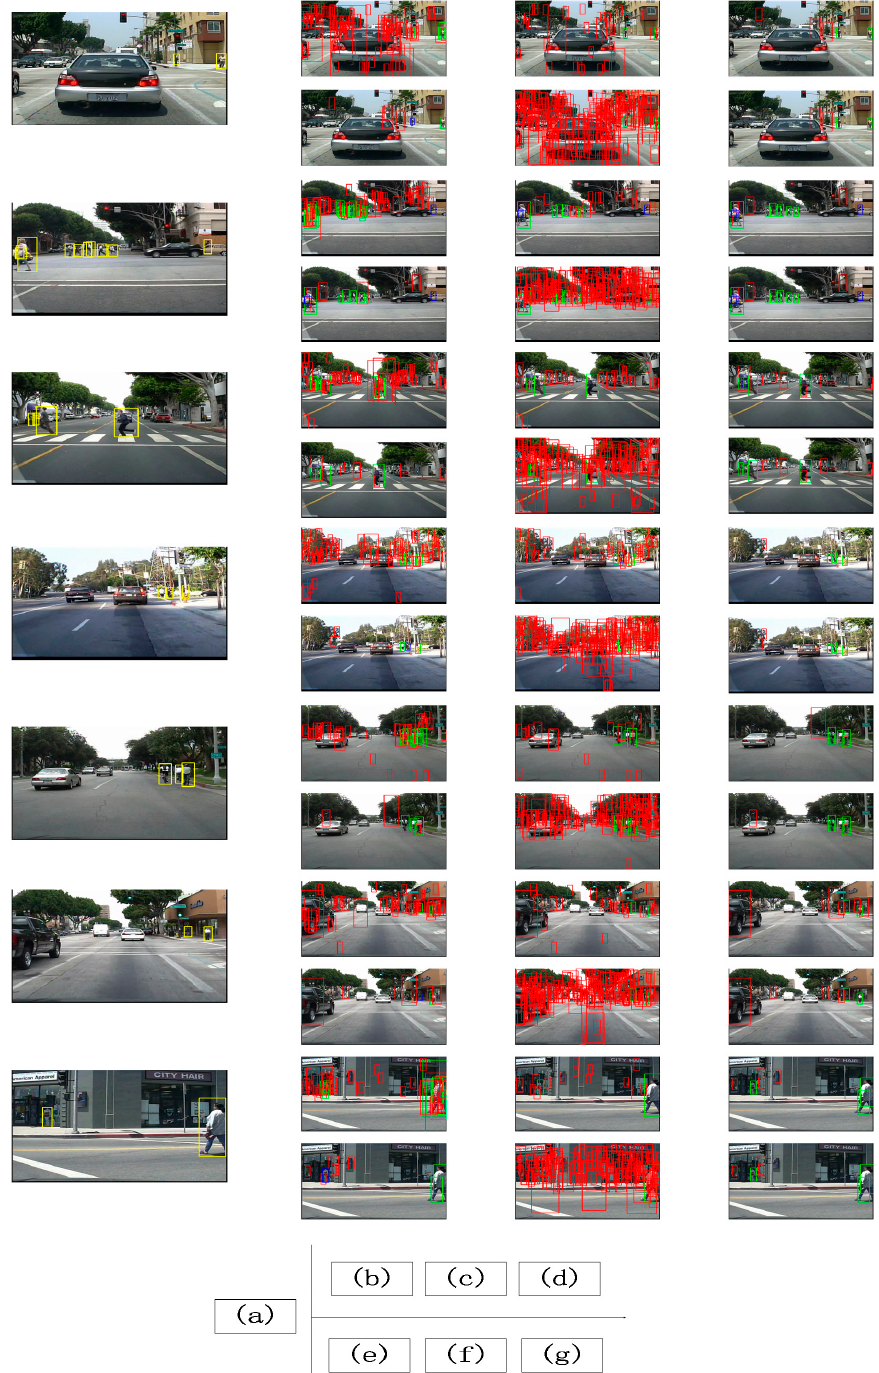
Figure 14. Detection results of models based on shallow networks. False positive samples are in the red box. True positive samples are in the green box. False negative samples are in the purple box. ( a ) Ground truth; ( b ) DBN-Isol; ( c ) DBN-Mul; ( d ) UDN; ( e ) SDN; ( f ) MultiSDP; ( g ) Two-stream UDN (ours). Best viewed in color.